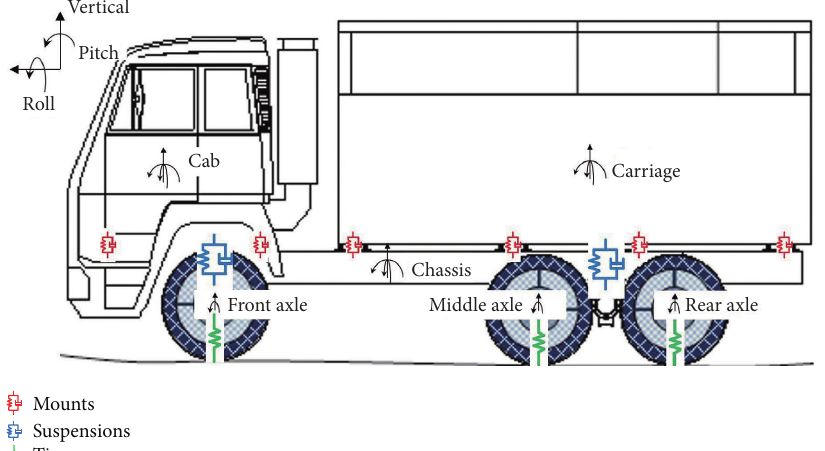
Figure 1: Schematic of the heavy-duty vehicle model.